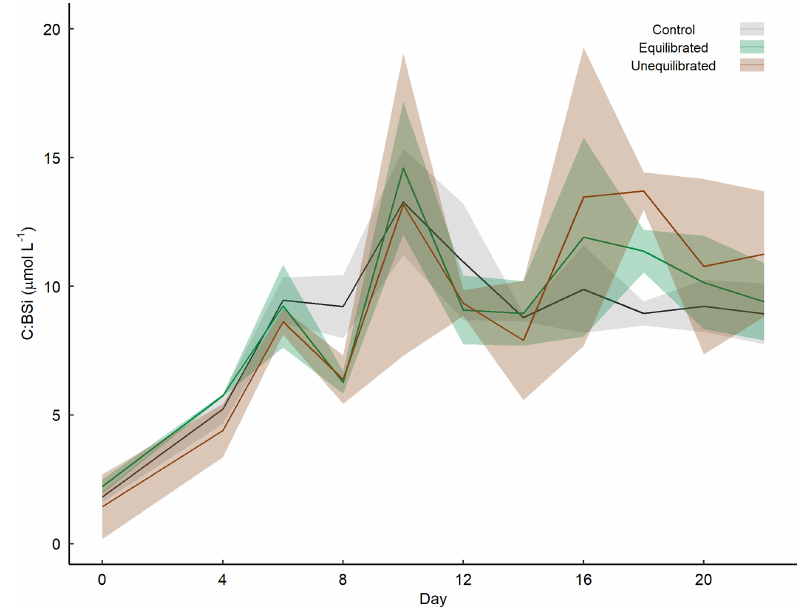
Figure A6. Temporal variation in the molar ratios of TPC to BSi within microcosms. Coloured shading around the respective means repre- sents the standard